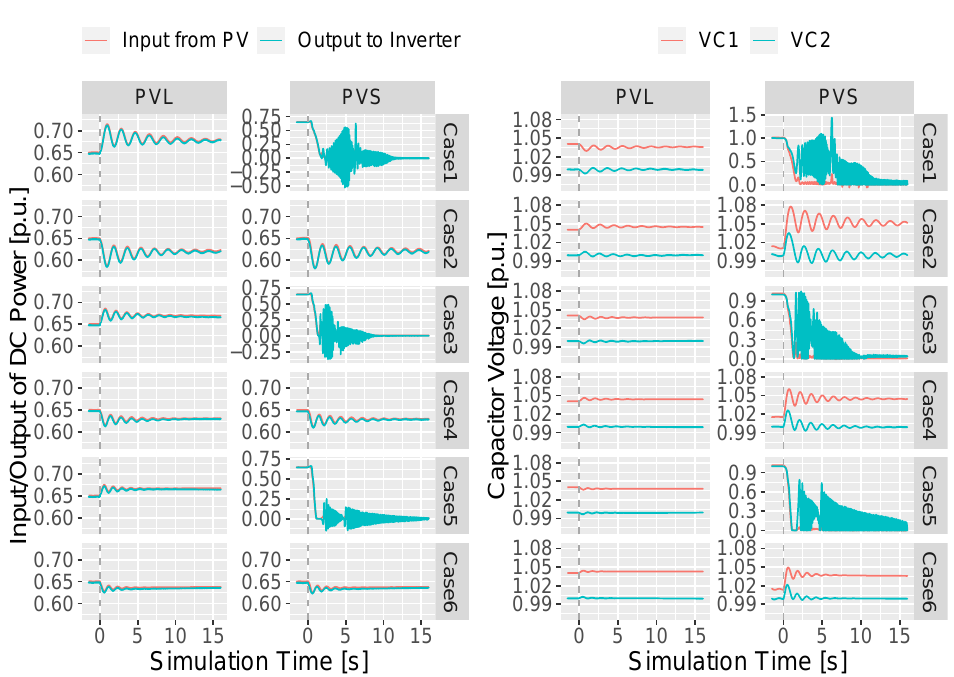
Figure 8. Active power flow and the capacitors’ voltage of the DC/DC converter. VC1 implies PV side voltage, and VC2 implies the inverter side voltage.